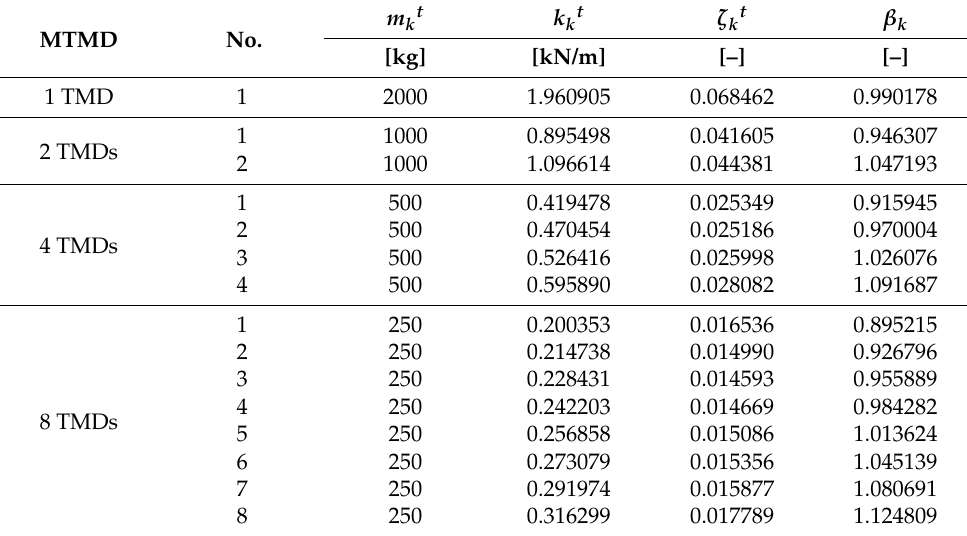
Table 3. Optimal k kt , ζ kt , β k values obtained for the J 1 objective function.